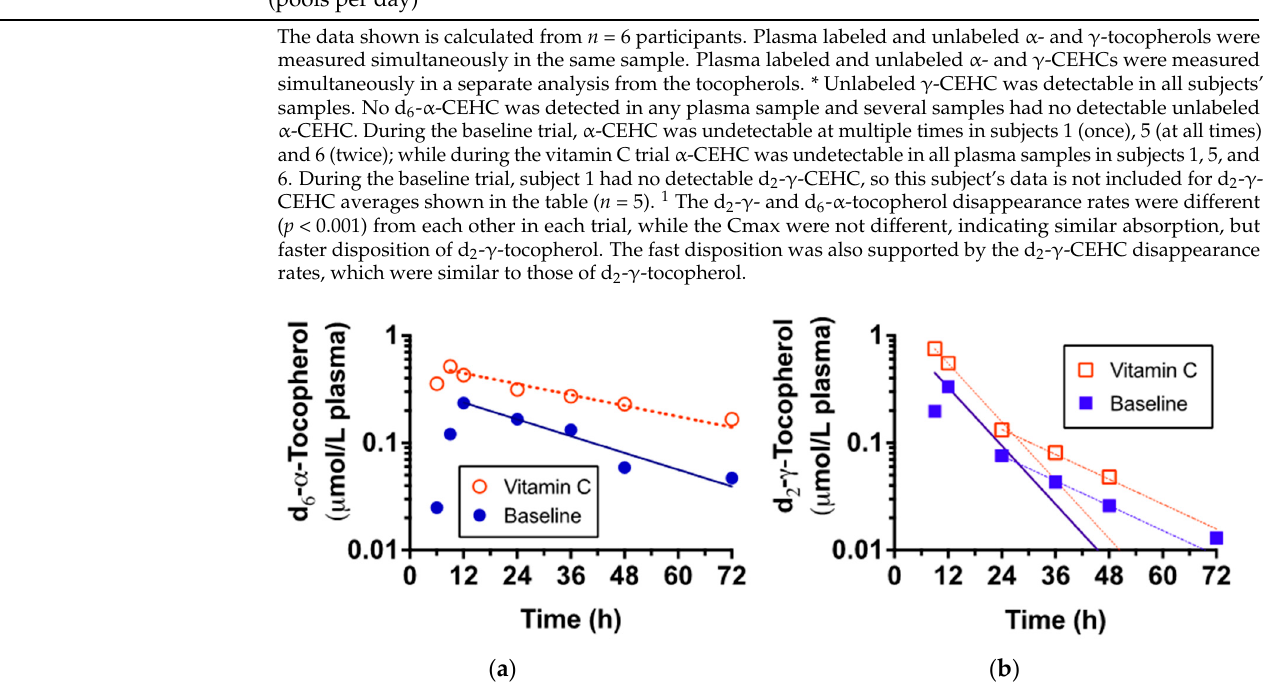
Figure 2. The plasma d 6 - α - ( a ) and d 2 - γ -tocopherol ( b ) concentrations at baseline and after vitamin C supplementation (representative participant, #3). Plasma-labeled and unlabeled tocopherols were measured by LC/MS from blood samples periodically collected up to 72 h. Filled symbols denote baseline, open symbols denote vitamin C pharmacokinetics trial. Lines indicate post-peak exponential decay curves. The d 2 - γ -tocopherol rates of disappearance were so fast that the slopes were no longer linear after 36 h; thus, a second curve was fit to the data. Neither slope was altered by vitamin C status; only the slope from Tmax is reported.